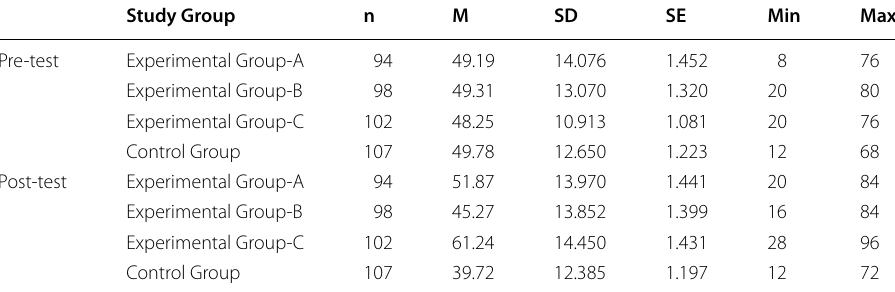
* The highest score you can get from the AAT is 100 Table 5 The ANCOVA results